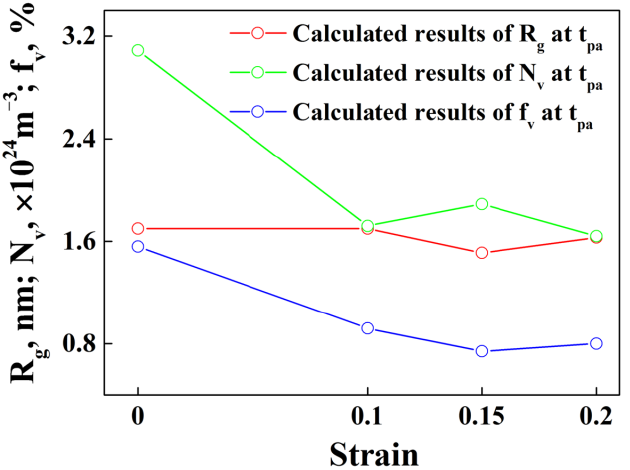
Figure 13. Average radius, number density and volume fraction of precipitates at peak aging ( t pa ) for alloy samples with different strains.